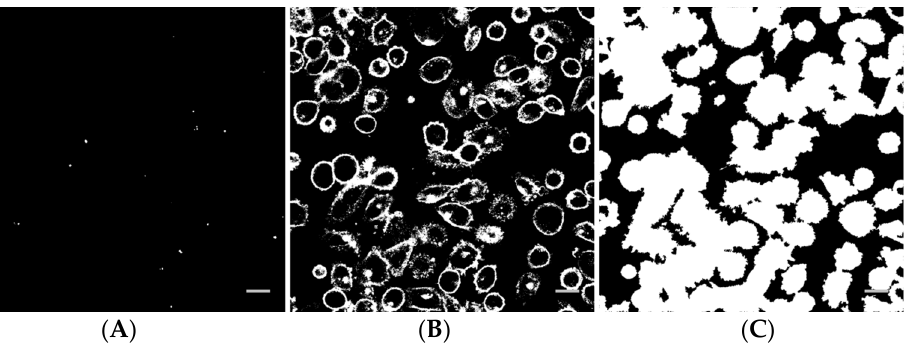
Figure 2. Example of a binary nanoparticle image ( A ), cell surface image ( B ) and cell image ( C ) as used for image analysis. The scale bars are 20 µm.